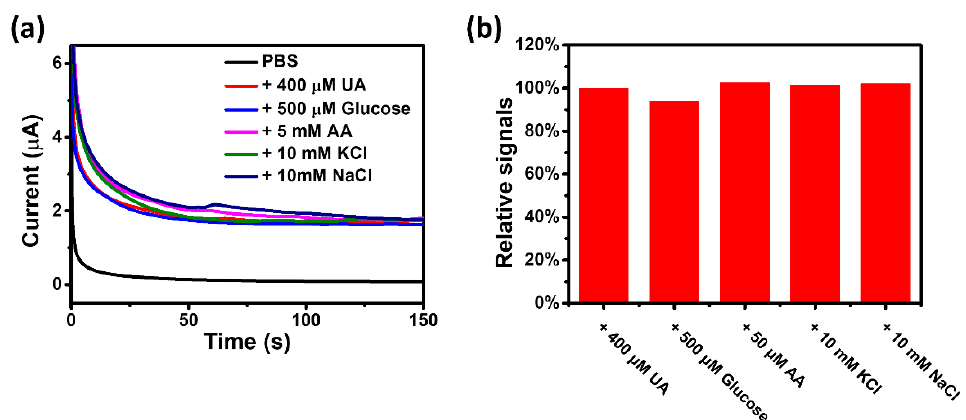
Figure 4. ( a ) The chronoamperometric responses of the UAS for adding uric acid and different interfering substances. ( b ) Statistical results of the effect of each interfering substance on the signal of the UAS.